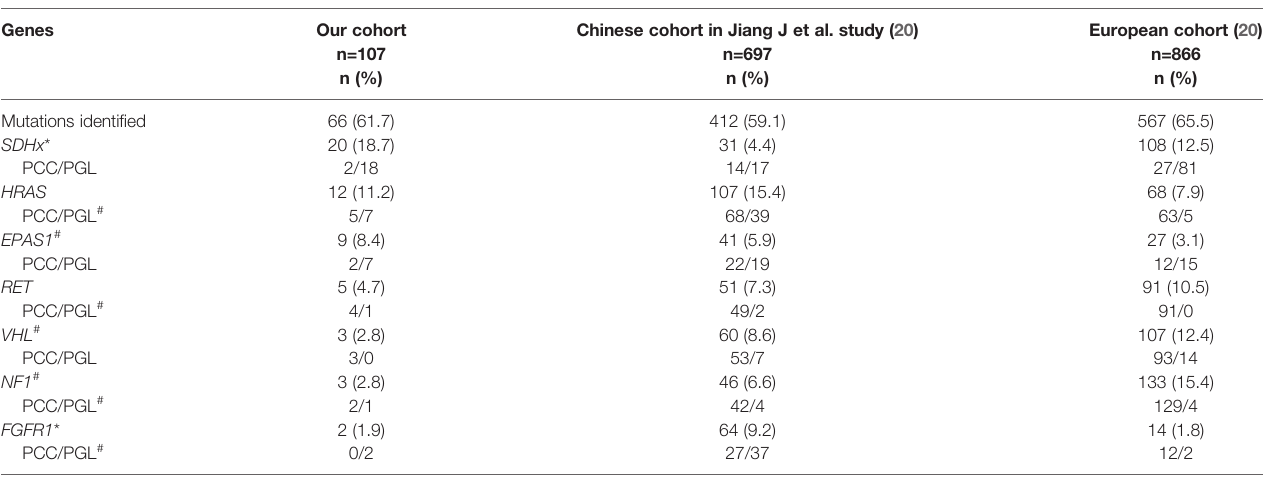
PCC.pheochromocytoma; PGL.paraganglioma; *Signi fi cant difference (P < 0.05) in the observational values between our cohort and the study by Jiang J et al. study. # Signi fi cant difference (P < 0.05) in the observational values between our cohort and the study by European